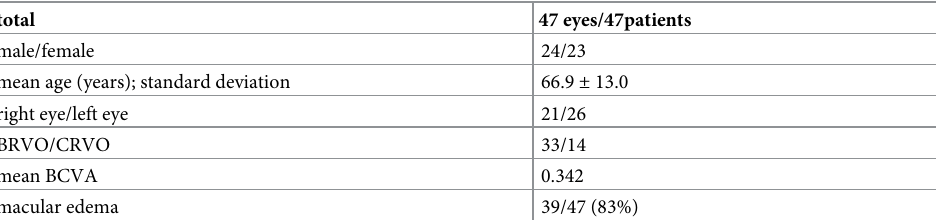
Table 1. Patient